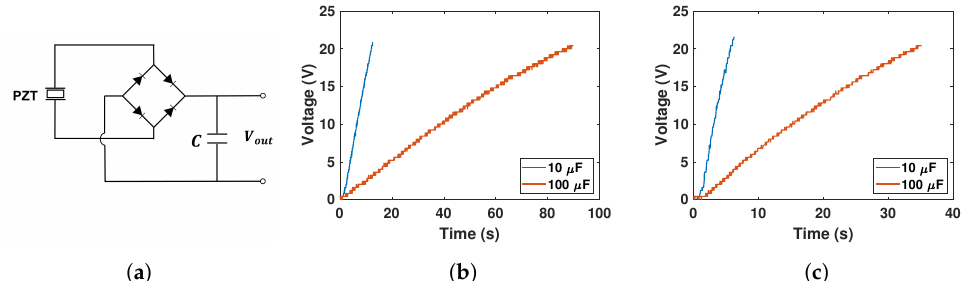
Figure 13. ( a ) An electrical circuit diagram for charging a capacitor. ( b ) The capacitor charging response of the MPVEH at a series connection. ( c ) The capacitor charging response of the MPVEH at a parallel connection.